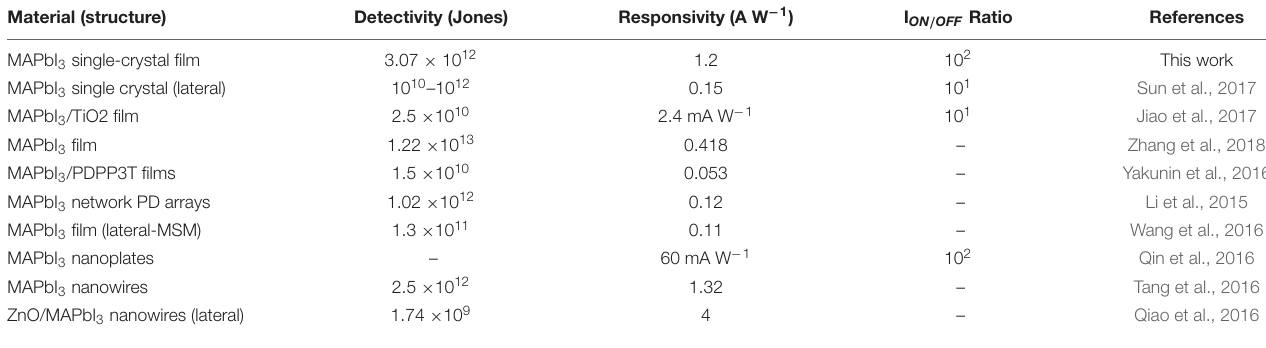
FIGURE 4 | (A) Dark current of our photodetector and MAPbI 3 PSC-based photodetector under different voltage bias. (B) Photocurrent of our photodetector and MAPbI 3 PSC-based photodetector at 670 nm under 90 µ W cm − 2 light illumination intensity. (C) I ON /I OFF current ratios of our photodetector and MAPbI 3 PSC-based photodetector at 20 V bias under various light illumination intensity from 90 µ W cm − 2 to 3.2 mW cm − 2 . (D) Long-term dark current density test at 20 V bias. (E) Long-term response of devices after 120 days with a 0.5 Hz LED at 670 nm of 90 µ W cm − 2 as light source. TABLE 1 | Device performance comparison between MAPbI 3 -based